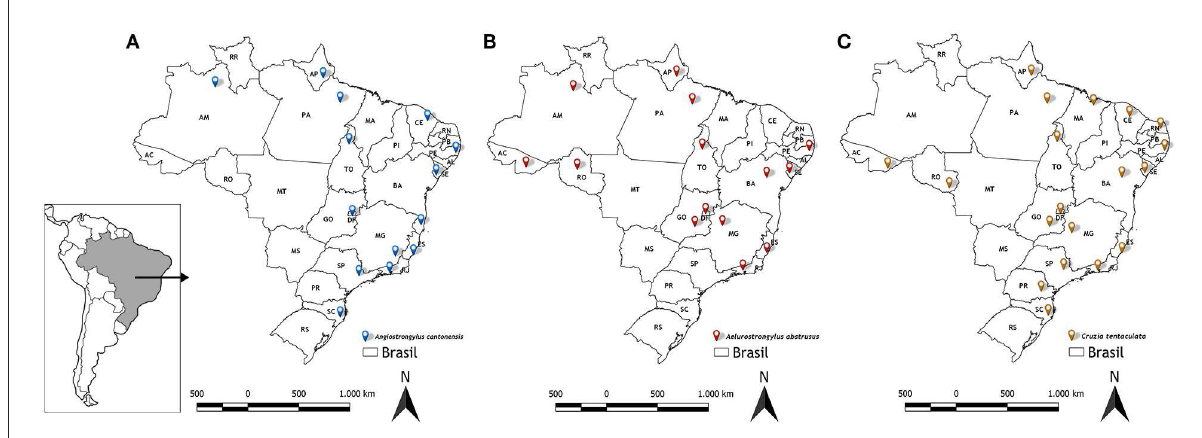
FIGURE6 Distribution of nematodes obtained from LRNEM analyzes from 2008 to 2021. (A) Angiostrongylus cantonensis , (B) Aelurostrongylus abstrusus, and (C) Cruzia tentaculata